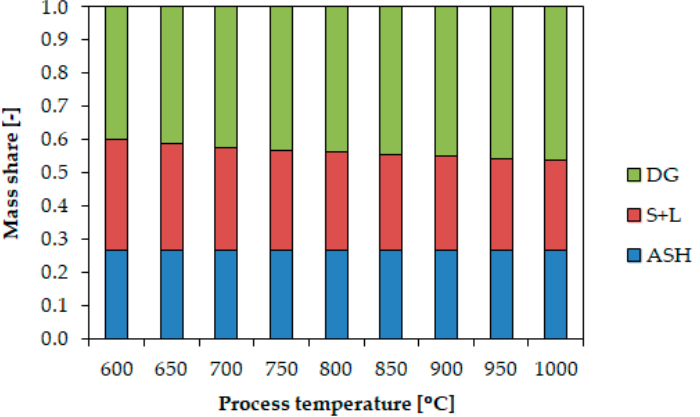
Figure 8. Distribution of the ASR 1 product fractions, 25 °C and residence time 2 s. Dry gas (DG), solid and liquid products (S + L), and ash (ASH).